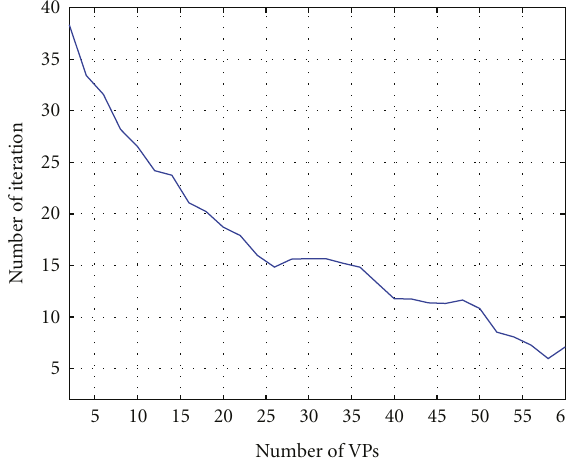
Figure 10: Iteration number for di ff erent number of VPs.